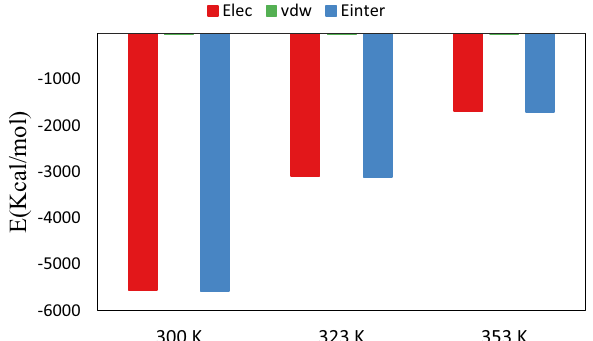
Figure 10. Intermolecular interaction energy, E inter , Van der Waals, E vdW , Electrostatic, E coul , between MEN: MEN for the binary mixtures of menthol and fatty acid with %LUA = 44 at different temperatures.